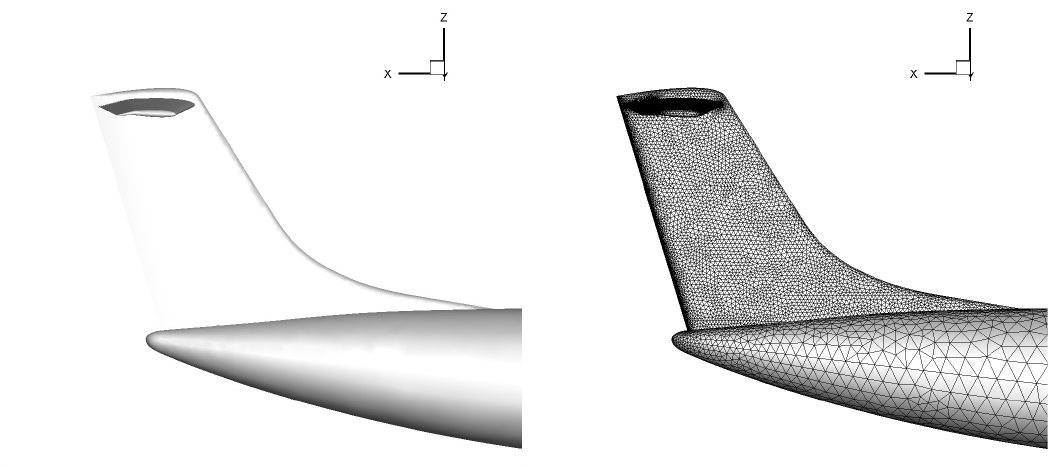
Figure 7. Right elevator: side views of CAD model ( left ) and surface mesh ( right ) for δ e = + 10 ◦